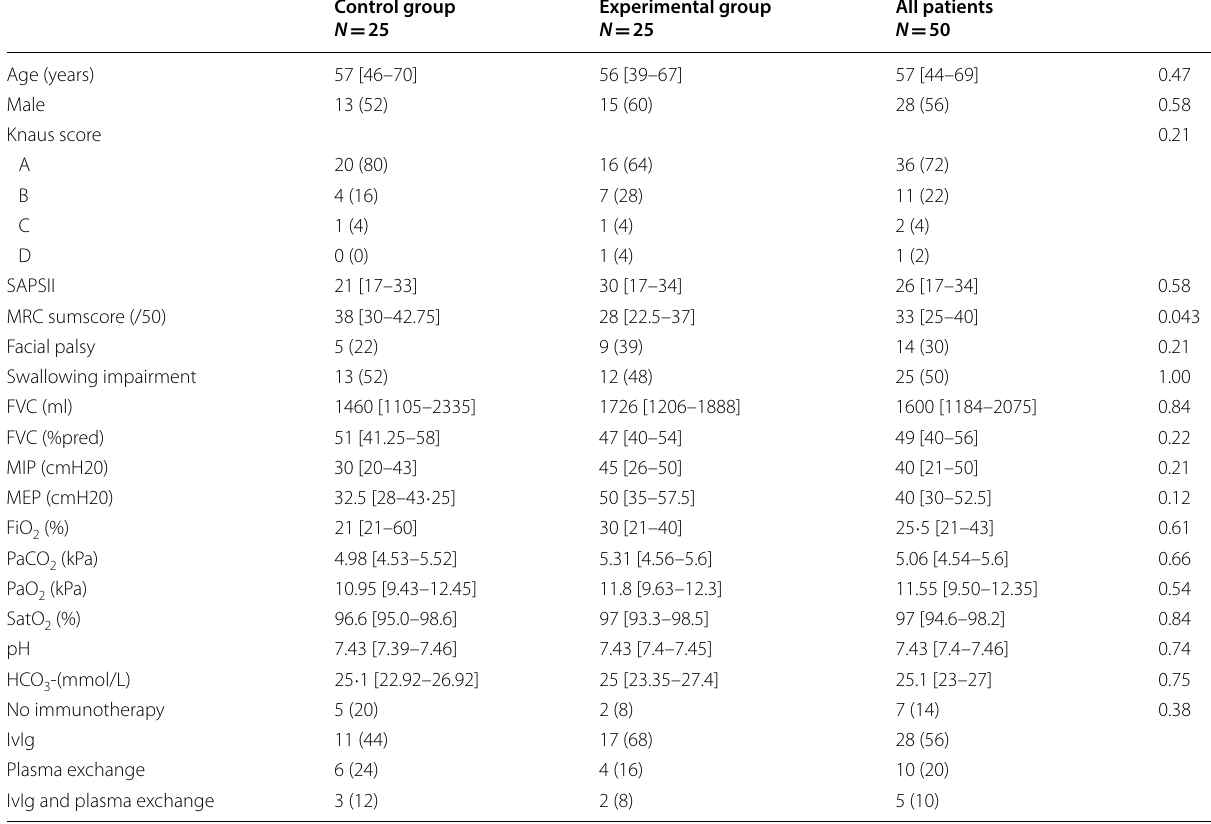
Table 1 Baseline characteristics